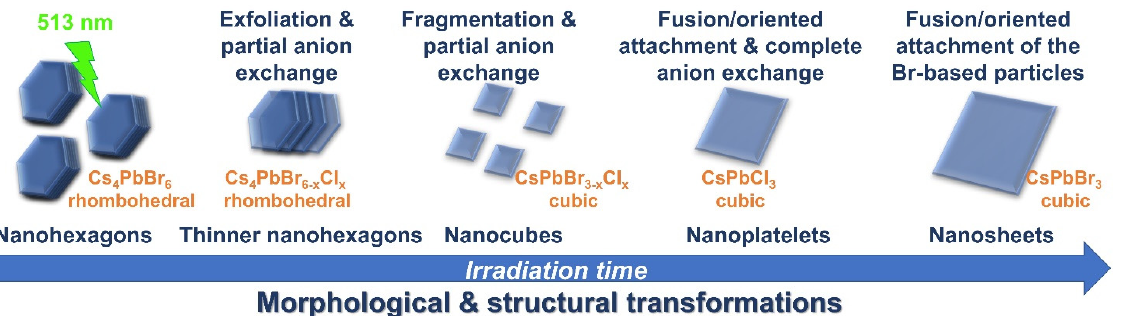
Figure 1. Photo-triggered morphological and structural transformations of metal halide